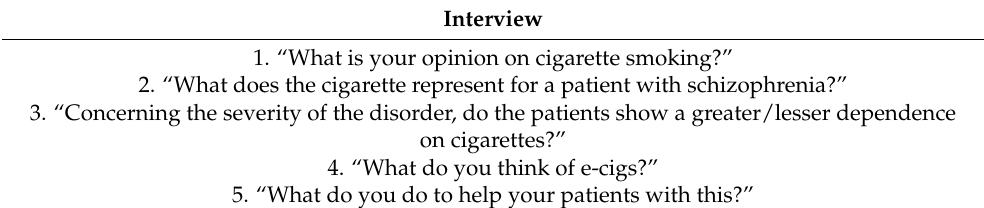
Table 2. Research